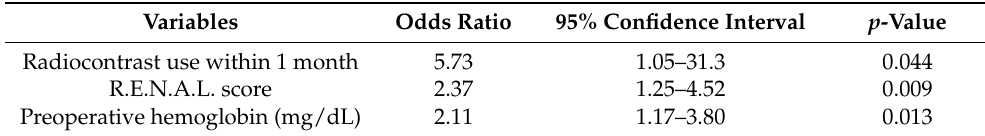
Table 4. Multivariable logistic regression analysis of the risk of acute kidney injury after par- tial nephrectomy.